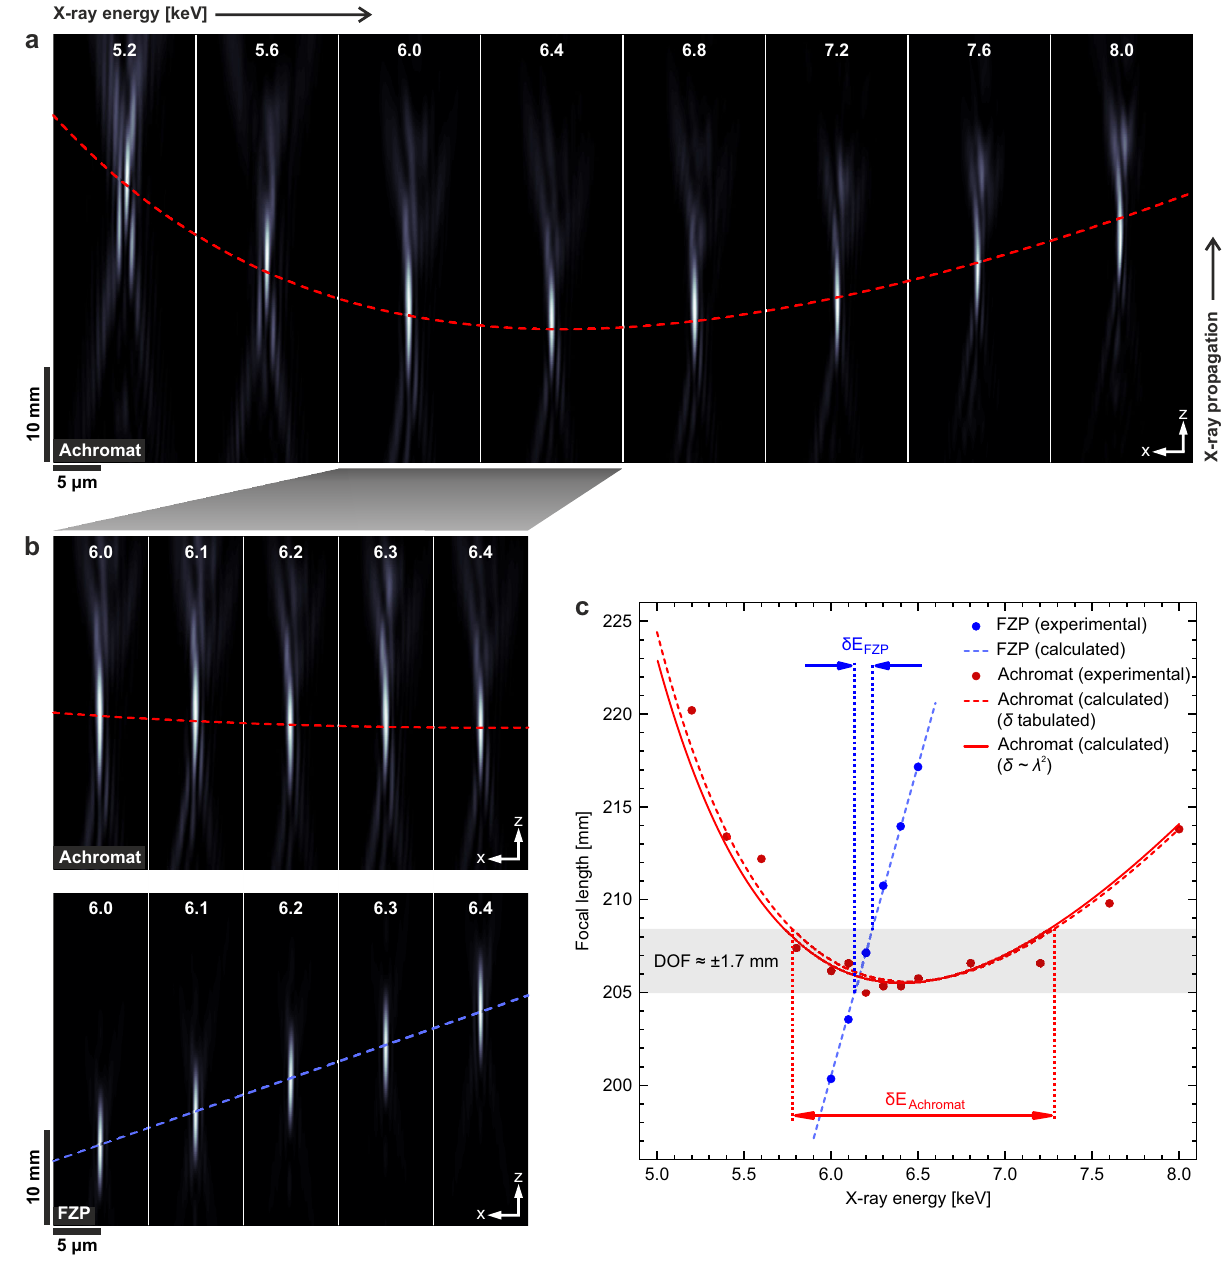
Fig. 3 Evolution of the X-ray beam pro fi le with the energy measured with ptychography. a Caustics at energies from 5.2 keV to 8.0 keV obtained with the achromat. The red dashed line indicates the location of the focal plane at the different energies. b Comparison of the caustics obtained with the achromat and the FZP. While the position of the focal plane remains almost constant with the energy for the achromat (red dashed line), it changes rapidly for the FZP (blue dashed line). c Calculated curves (solid and dashed lines) and experimental data (dots) for the focal length versus energy for the FZP (blue) and the achromat (red; solid: based on Eq. (6), dashed: based on tabulated refractive index values for the calculation of f RL at each with an energy range between 5.6 keV and 6.8 keV obtained with an achromat. The gain in image quality compared to the image in Fig. 4b simulated analogously using a FZP as an optical element is striking. The image contrast is signi fi cantly improved with the achromat, which in the presence of noise enables the visualisation of much smaller features. The improvement in image quality can be understood from the simulated polychromatic beam pro fi les in Fig. 4c, where much stronger side lobes of the beam can be observed for the FZP than for the achromat.